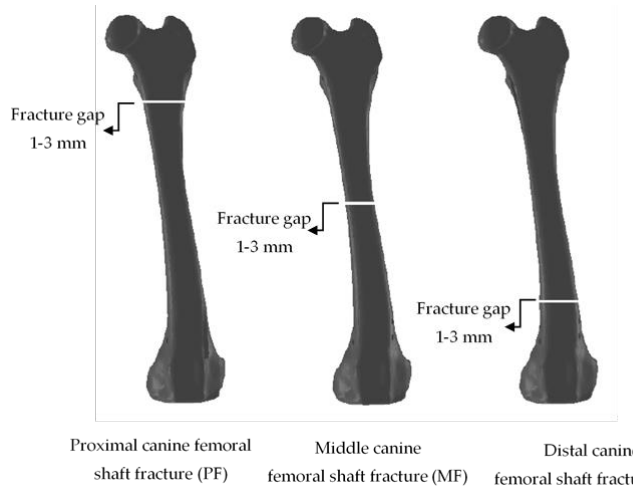
Figure 1. The three types of canine femoral shaft fractures.